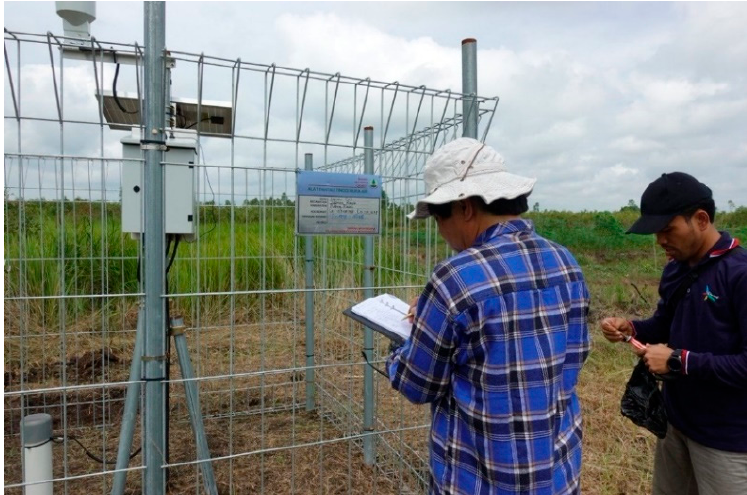
Figure 1. Real-time WT depth monitoring station in Jabiren, Pulang Pisau Regency, Central Kalimantan, Indonesia (Source: Twitter of BRG Indonesia).